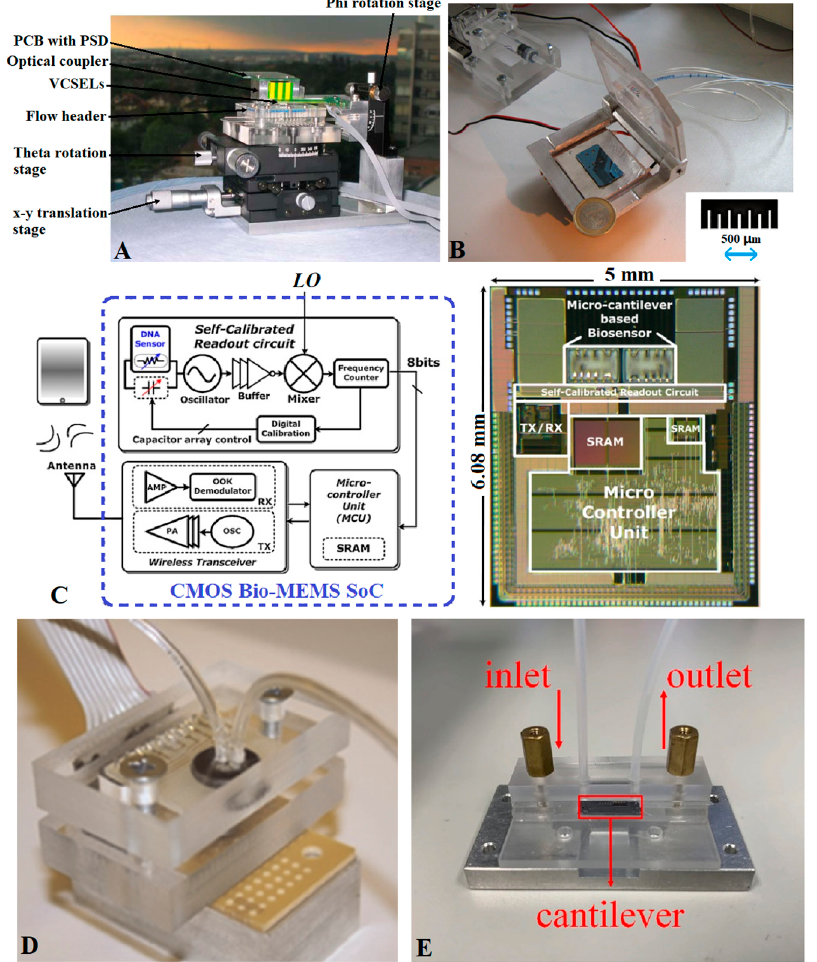
Figure 14. ( A ) Integrated testing equipment of Lechuga et al. [67]; ( B ) integrated testing equipment of Ricciardi et al. [175]; ( C ) integrated testing equipment of Huang et al. [176]; ( D ) integrated testing equipment of Khemthongcharoen et al. [142]; ( E ) integrated testing equipment of Wang et al. [184].